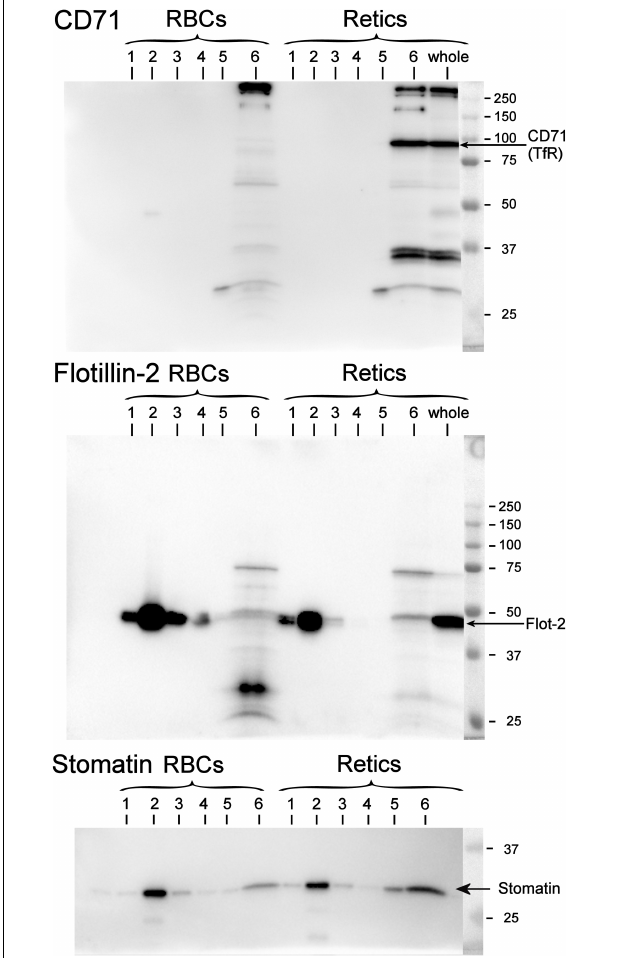
FIGURE 5 | Partitioning of TfR, flotillin-2 and stomatin between the raft and non-raft phase in RBCs and Retics. Six fractions of a sucrose gradient from a mini-preparation of membrane rafts as DRM from Retics and RBCs were probed by Western blotting for CD71, flotillin-2 and stomatin. Membrane rafts partition in fraction 2 from the top of the gradient, as shown by the presence of flotillin-2 and stomatin in this fraction for both Retic and RBC samples. In the Retic sample the TfR is only detected in the non-raft fraction at the bottom of the gradient (fraction 6). “Whole” is a sample of whole Retics. See text for details.